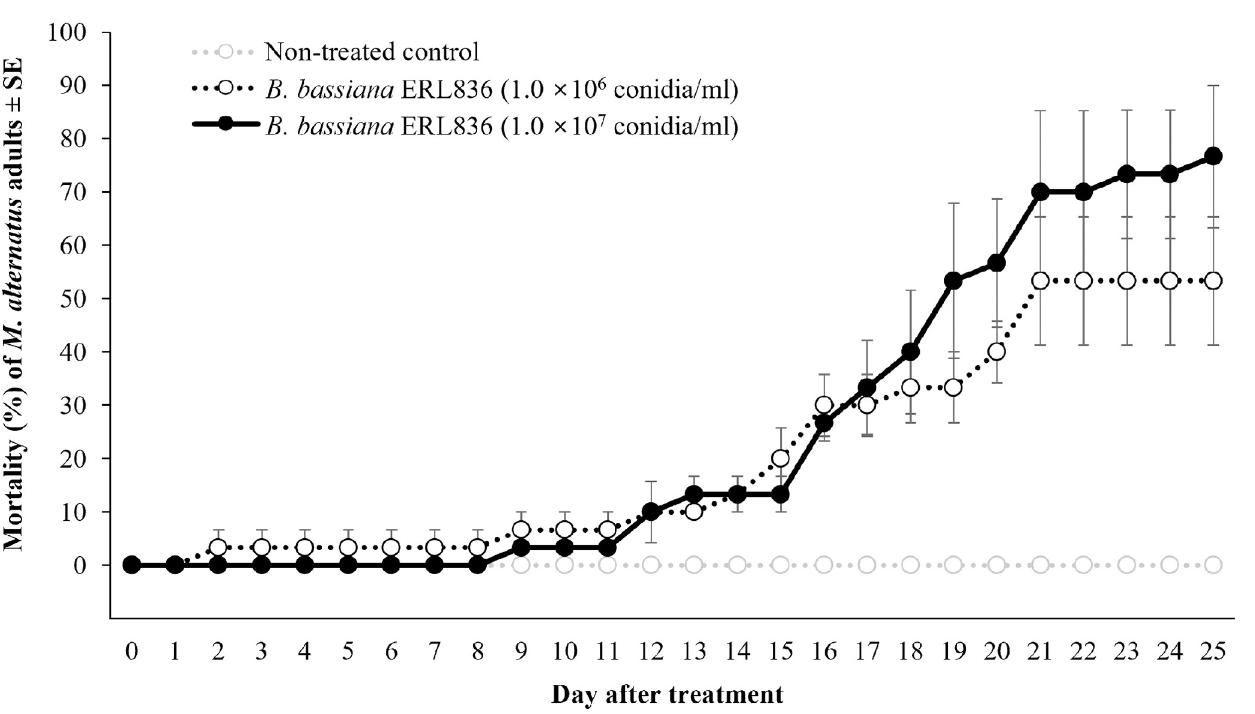
Fig 1. Mortality of M . alternatus adults in small pine trees pre–treated with B . bassiana ERL836 in pot conditions. B . bassiana ERL836 conidia suspension (1.0 × 10 6 or 1.0 × 10 7 conidia/ml) was treated on four pine trees in a pot (40 × 30 × 30 cm) and ten M . alternatus adults were released into the pot (10 adults/ pot). The numbers of alive and dead adults were counted